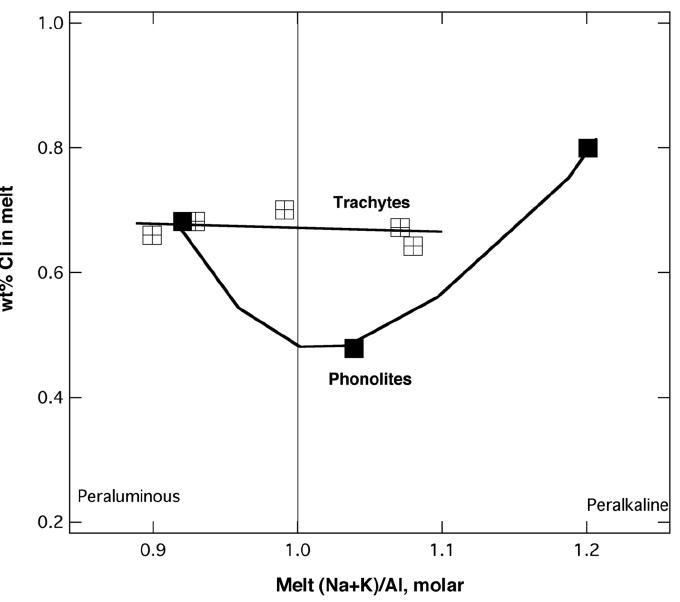
Fig. 6. Solubility of chlorine ( ± 1 standard deviation) at 100 Mpa, 850-875°C as a function of molar [(Na+K)/Al] ratio for natural trachytes (open symbols, from Signorelli and Carroll, 2002), and natural and synthetic phonolites (filled symbols, from Signorelli and Carroll, 2000) saturated with an aqueous fluid + hydrosaline